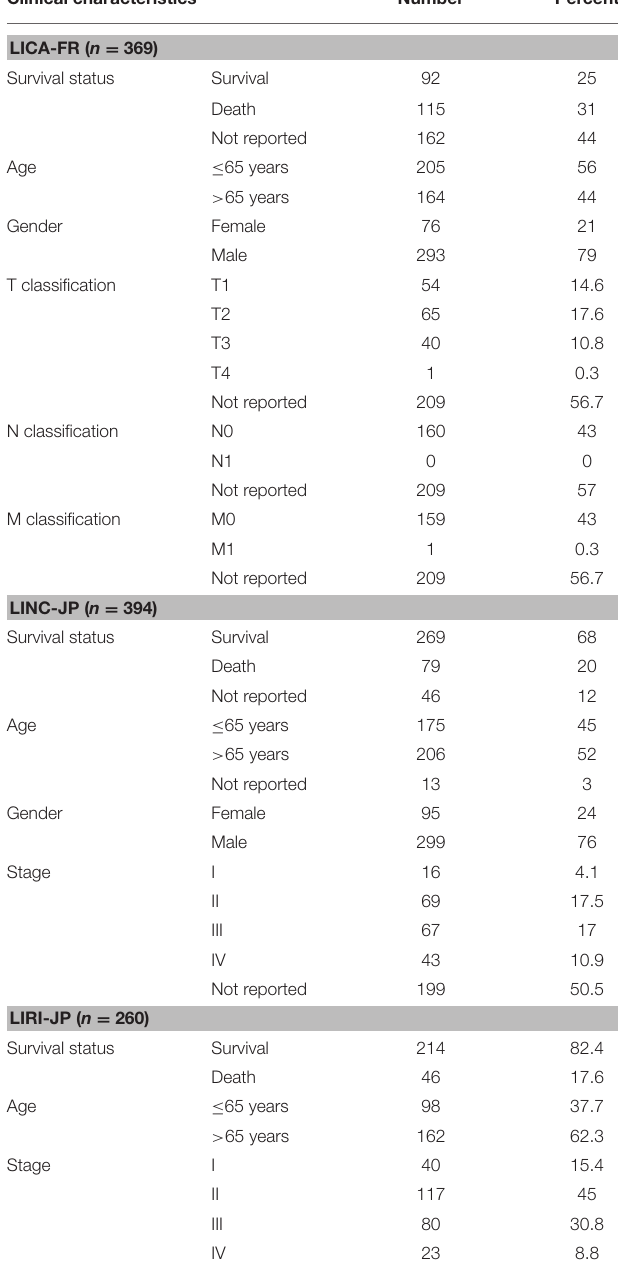
TABLE 1 | Baseline patient characteristic in three